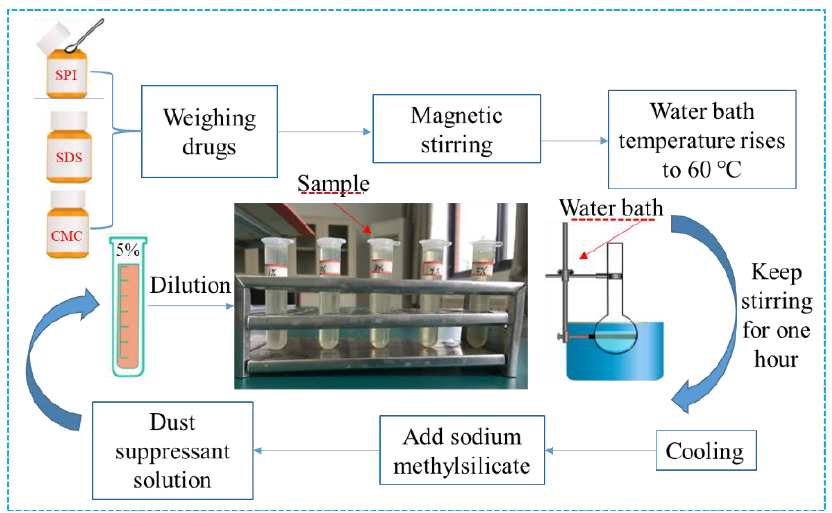
Figure 3. Flow chart of preparation of dust suppressant.